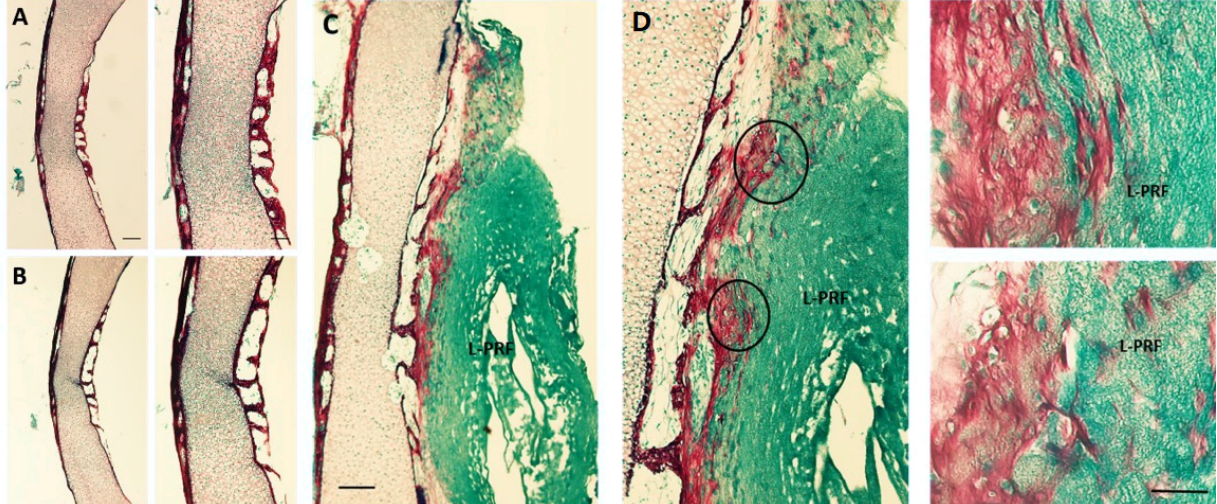
Figure 5. Representative histological images (Alcian blue/Sirius red stain) of the diaphyseal region of ED11 chick femora, after 11 days of organotypic culture without and with L-PRF membrane, in indirect and direct contact. ( A ) Control group, ( B ) indirect contact group and ( C ) direct contact group. Scale bar = 100 and 50 µm, respectively. ( D ) Represents magnified areas from the marked areas, scale bar = 20 µm.